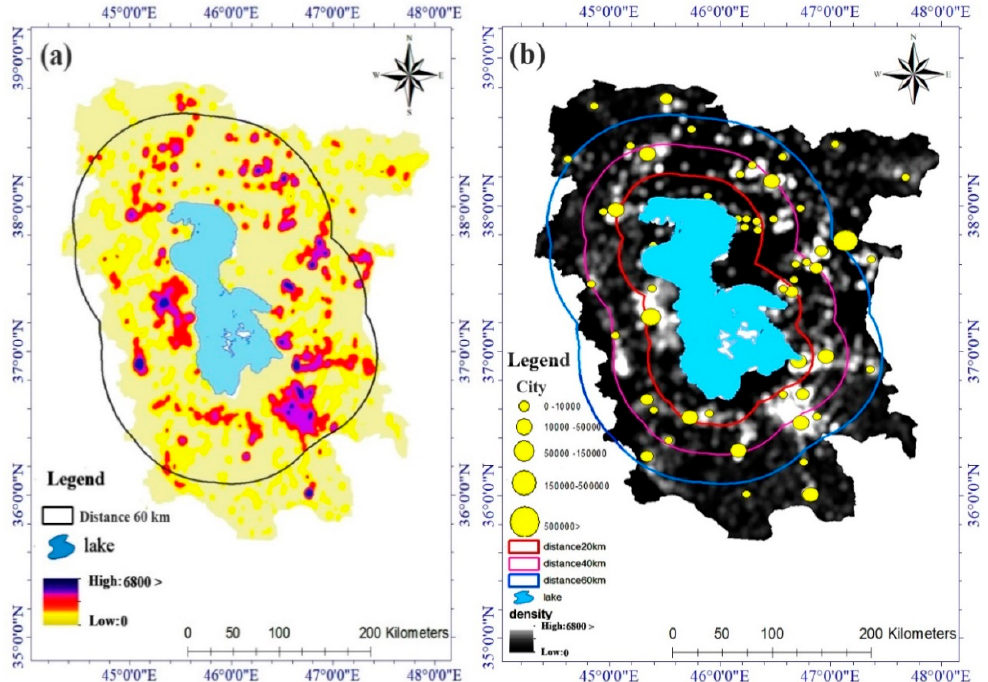
Figure 11. The impact of salt storms on the societies; ( a ) focal radius 60 km from Lake Urmia and ( b ) the radius of the salt storm crisis on human centers.